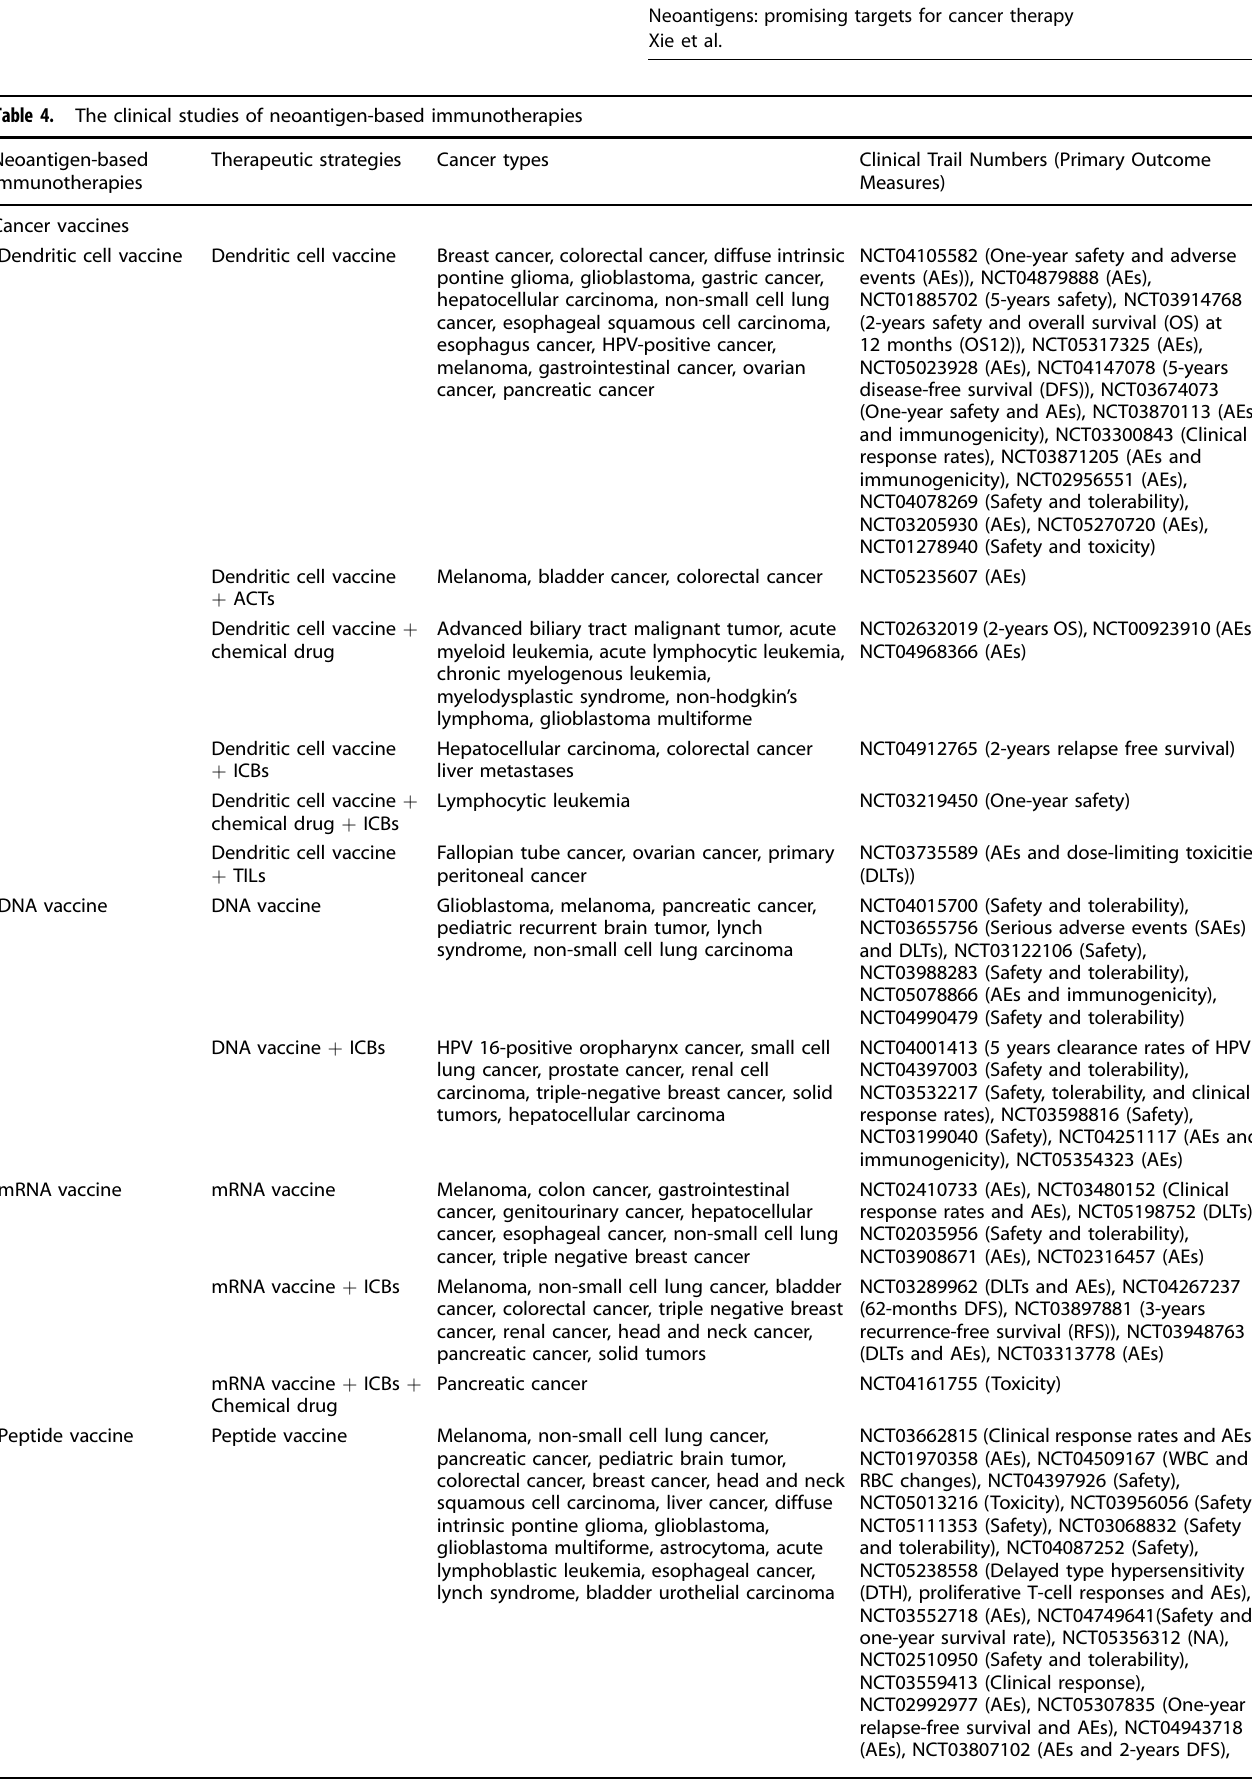
Table 4. The clinical studies of neoantigen-based immunotherapies Neoantigen-based Therapeutic strategies Cancer types Clinical Trail Numbers (Primary Outcome immunotherapies Cancer